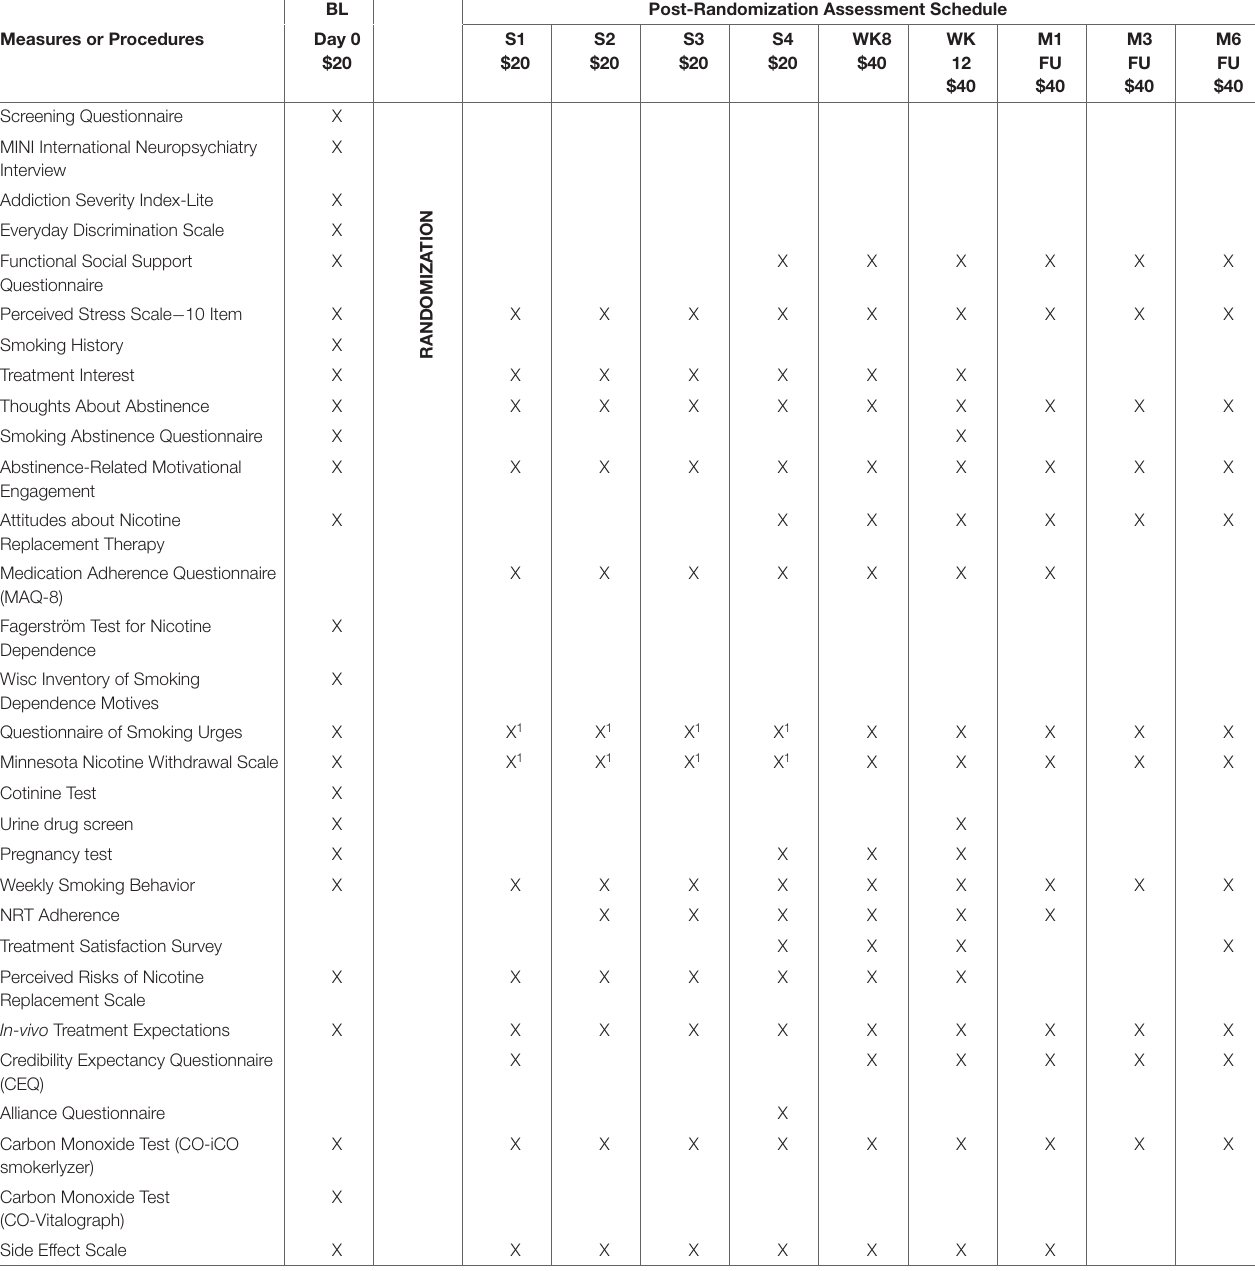
TABLE 1 | Study assessment